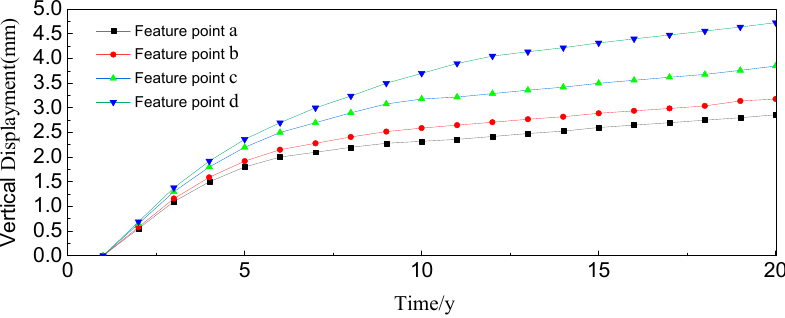
Figure 16. Canal settlement nephogram when t = 20 years.